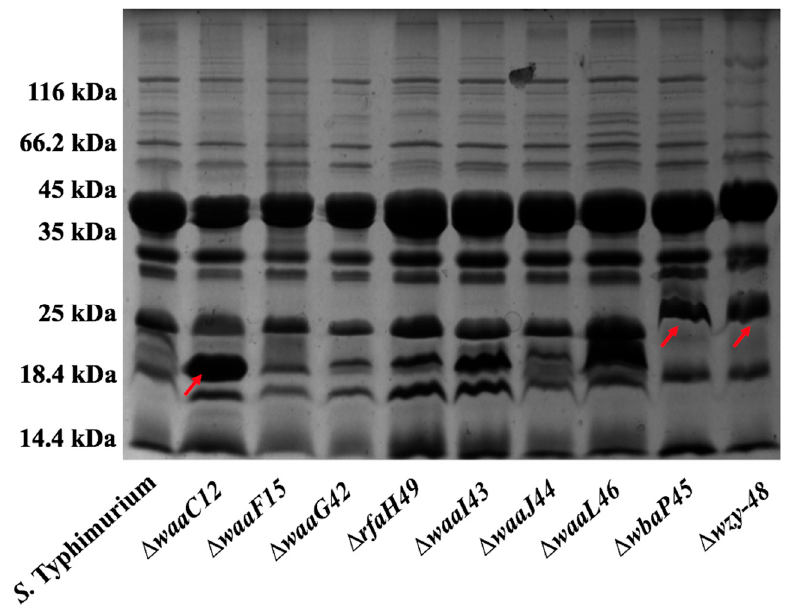
Figure 3. Outer membrane proteins’ (OMPs) profile. OMPs purified from the parent strain and its mutants were separated by sodium dodecyl sulfate polyacrylamide gel electrophoresis (SDS-PAGE) on 12% gel and subjected to Coomassie brilliant blue staining. The mutant strains (from left to right): S100 (wild-type strain), S511 ( ∆ waaC12 ), S512 ( ∆ waaF15 ), S372 ( ∆ waaG42 ), S377 ( ∆ rfaH49 ), S373 ( ∆ waaI43 ), S374 ( ∆ waaJ44 ), S376 ( ∆ waaL46 ), S375 ( ∆ wbaP45 ), S378 ( ∆ wzy-48 ). The red arrows represented the bands of differential proteins.